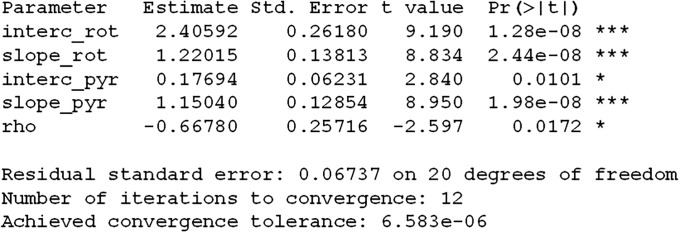
The output of program nls for estimation of the probit-based two-drug copula model (11).